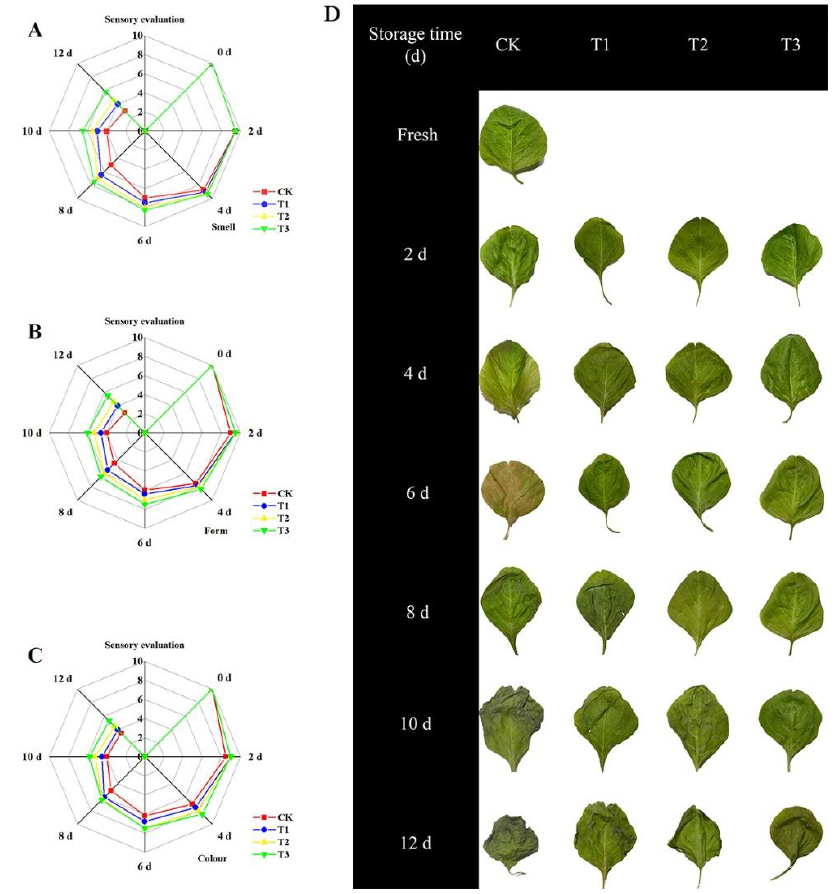
Figure 2. Changes in smell ( A ), form ( B ) and color ( C ) sensory characteristics, and sample shelf-life changes ( D ) during